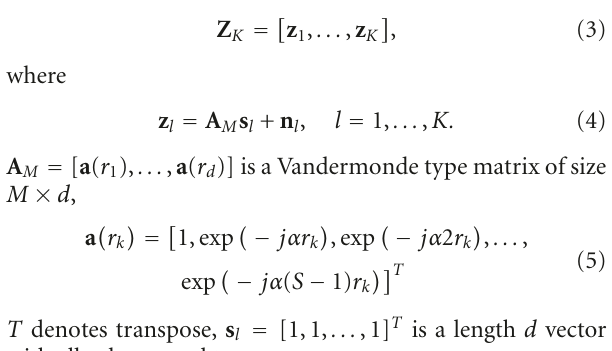
antenna such that